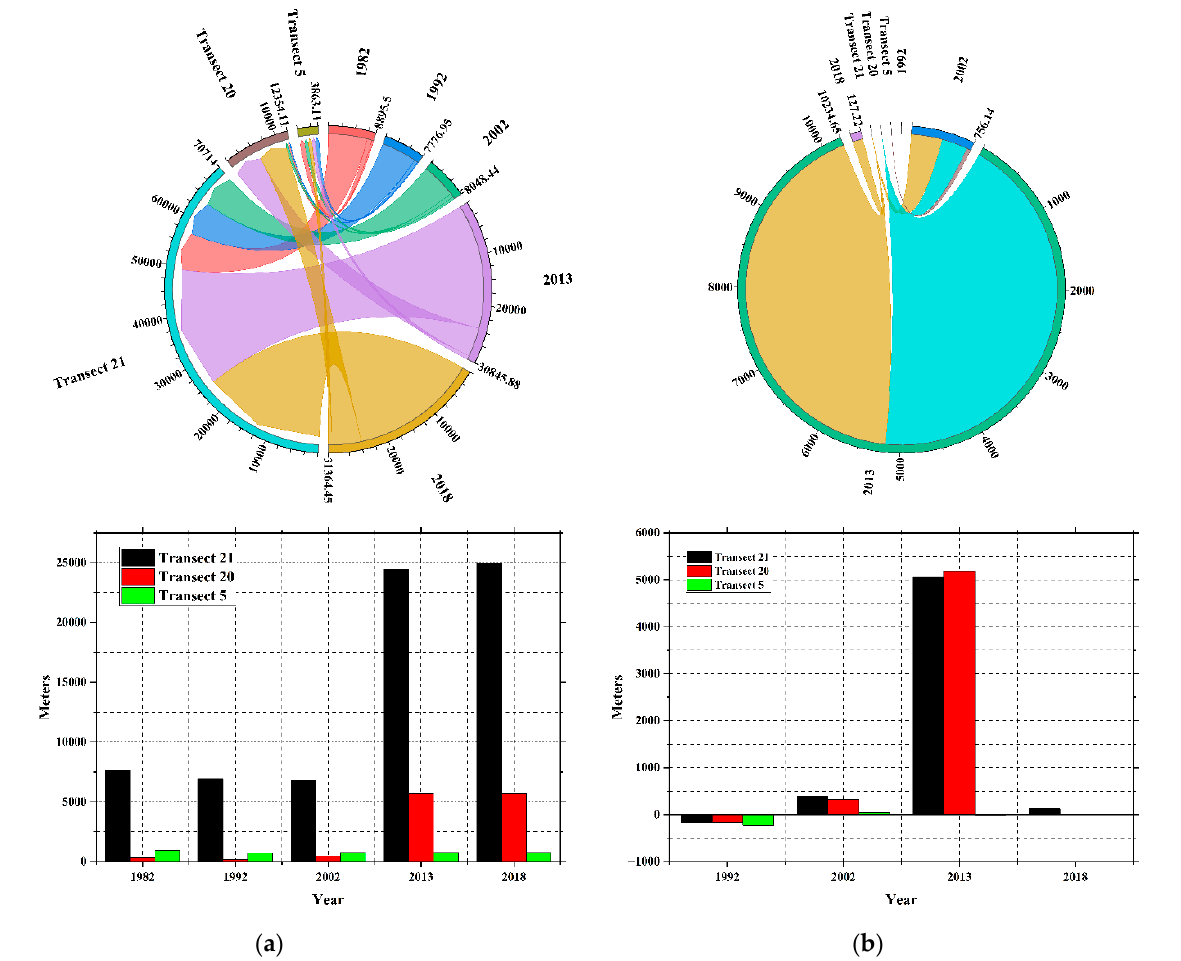
Figure 12. ( a ) Distance from baseline (m), ( b ) shoreline gain/loss in comparison to the last timeline (m).